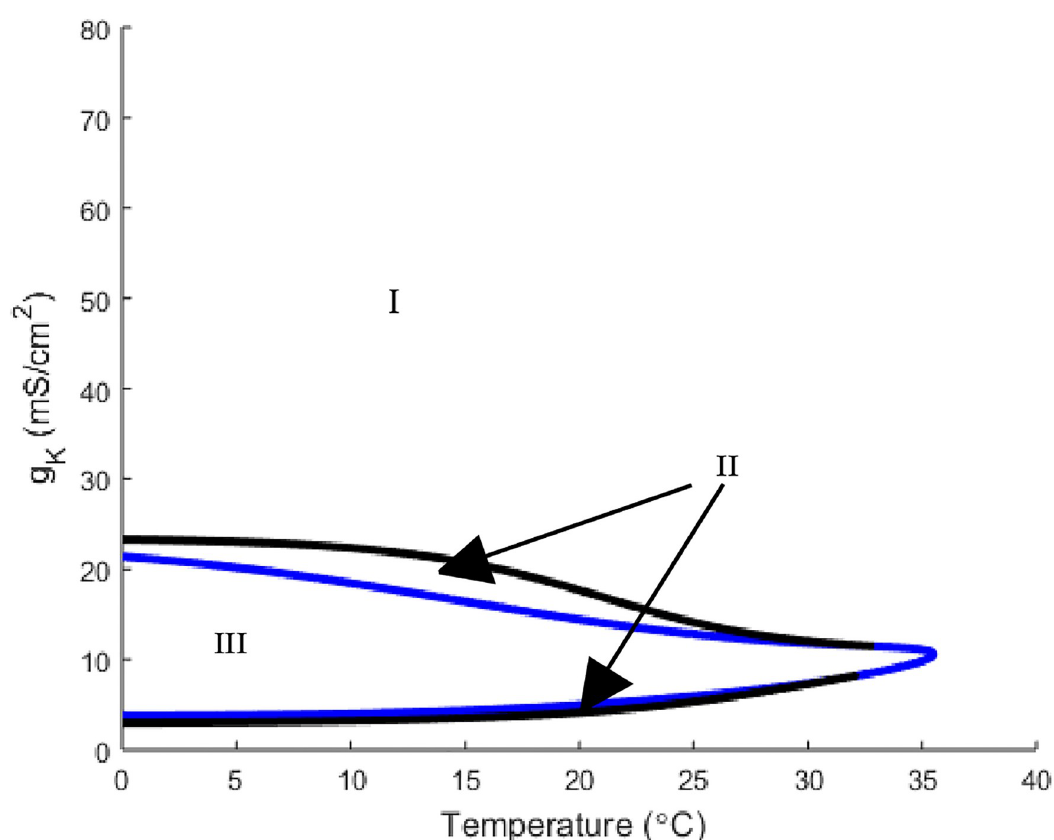
Fig 1. A two parameter bifurcation diagram of the Hodgkin-Huxley model depicting the relationship between temperature and g K . The blue curve represents the Hopf bifurcation while the black curve is a saddle-node-periodic (SNP) bifurcation. In region I there are no oscillatory solutions and only a stable steady state solution. In region II there is a stable and an unstable oscillatory solution in addition to a stable steady state solution. Region III has a stable oscillatory solution coexisting with an unstable steady state solution. cross the blue (Hopf) curve into region III resulting in the unstable oscillatory solution disap- pearing. This analysis is encapsulated by the horizontal and vertical one parameter slices of this bifurcation diagram depicted in Fig 2. The one parameter slices contain three regions of interest and four curves to keep track of. The regions are determined by the varying parameter along the x axis with all other parameters fixed for these plots. In region I we have only a stable steady state solution indicated by the red curve. In region II the steady state is still stable but there is an appearance of a stable oscillatory solution whose amplitude is indicated by the green curve and an unstable oscillatory solution which has an amplitude indicated by the dotted blue curve. The final region III transitions to an unstable steady state with a stable periodic solution whose amplitude is the green dashed curve. These slices also showcase the Hopf bifurcation point which occurs at the meeting between black and red curves and a SNP point which occurs at the meeting between blue and green curves. Fig 2 shows more explicitly the features of the neuron’s membrane potential, V , in response to parameter changes. It is important to note that for the top panel in Fig 2, g was K decreased to 20 for any activation of the neuron to occur while recalling that the standard Hodgkin-Huxley value of g is 36. K